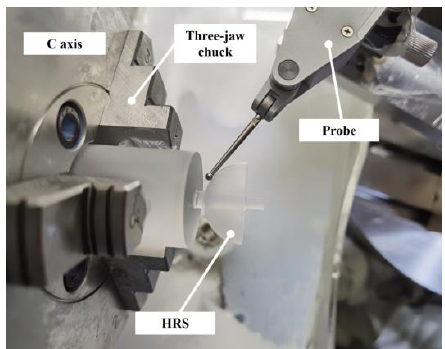
Figure 13. Profile and concentricity measurement of an HSR.